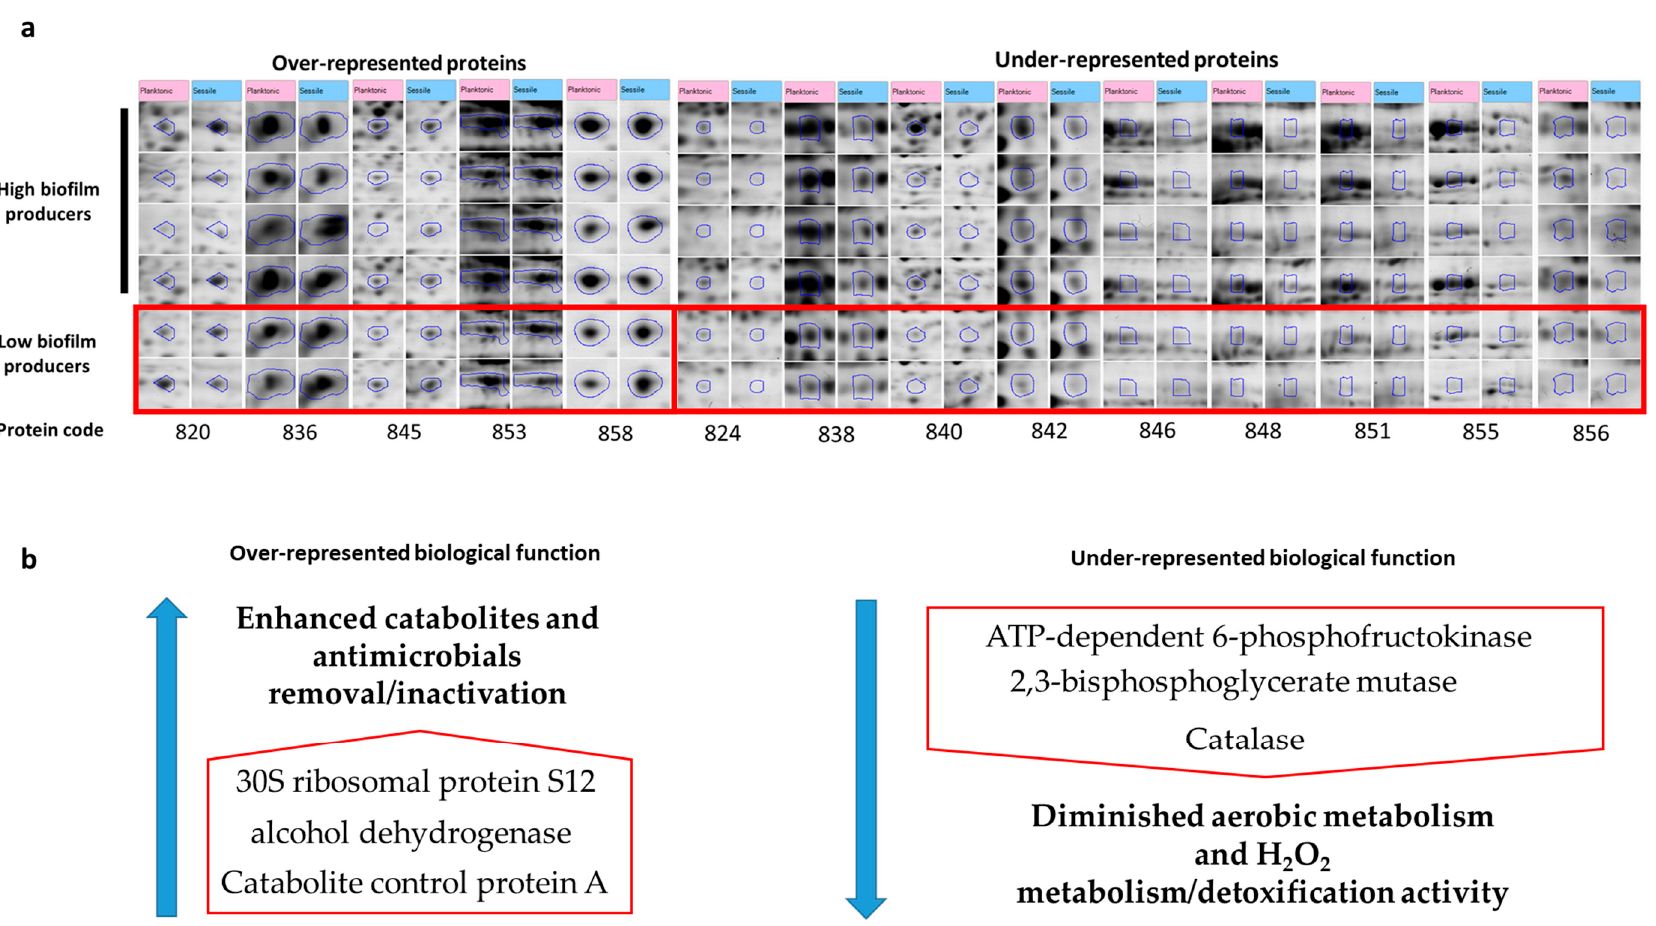
Figure 1. ( a ) Graphic representation of the differentially expressed proteins mostly relevant to the regulation of the described mechanisms/pathways. ( b ) Representation of the differentially regulated proteins and the related modulated mechanisms.